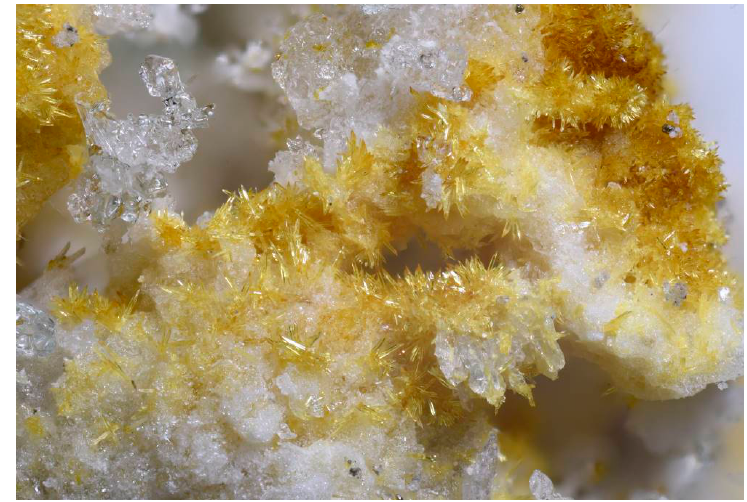
Figure 18. Magnanelliite, aggregates of prismatic yellow crystals, up to 0.5 mm, grown on alum-(K), from the Monte Arsiccio mine.